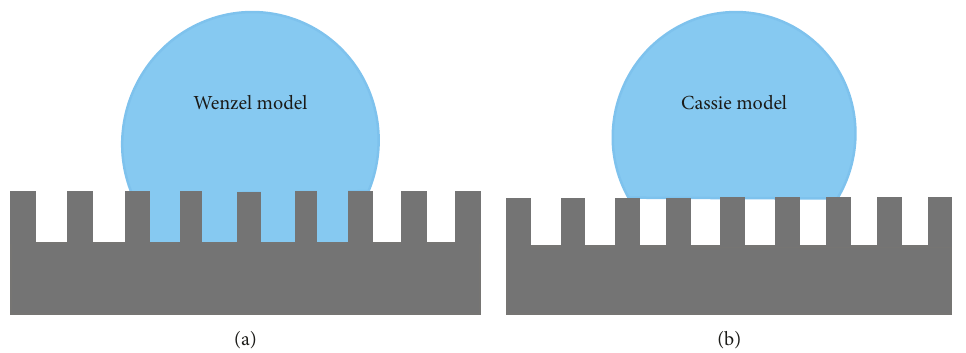
Figure 2: Droplet diagram of Wenzel and Cassie models on hydrophobic surfaces: (a) Wenzel model; (b) Cassie–Baxter model.